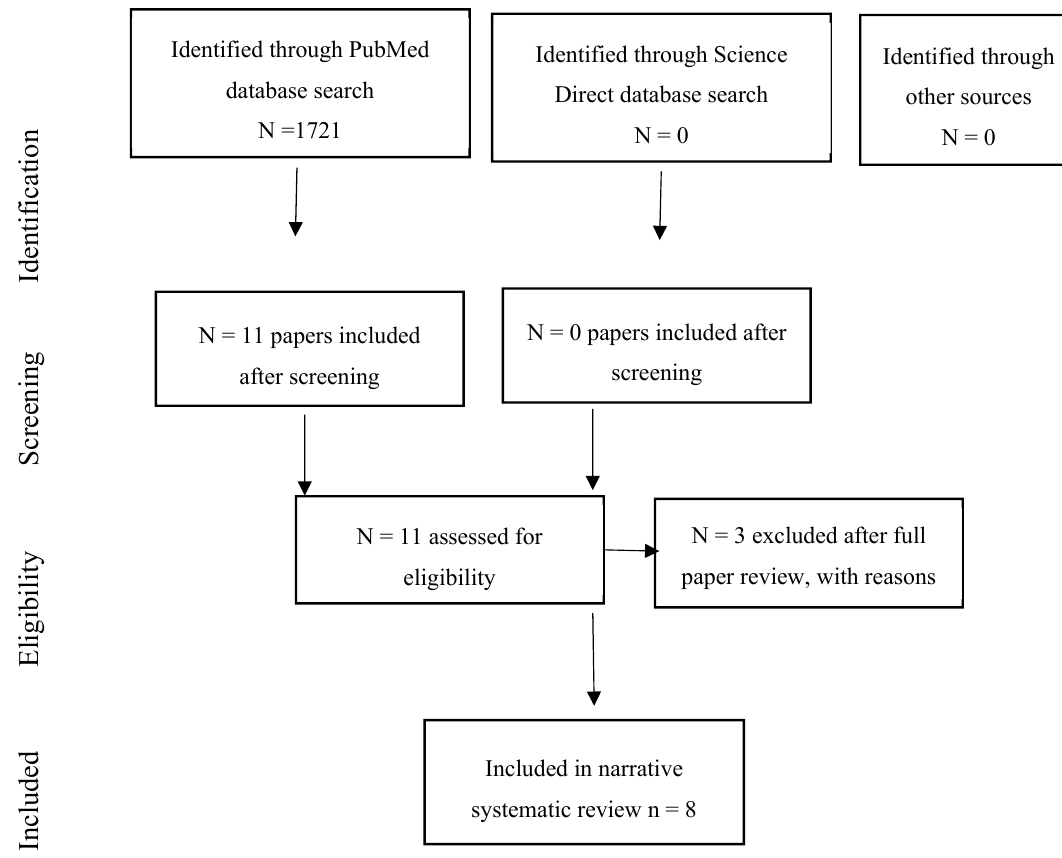
Figure 2. Flow chart showing the review process for the cancer papers.